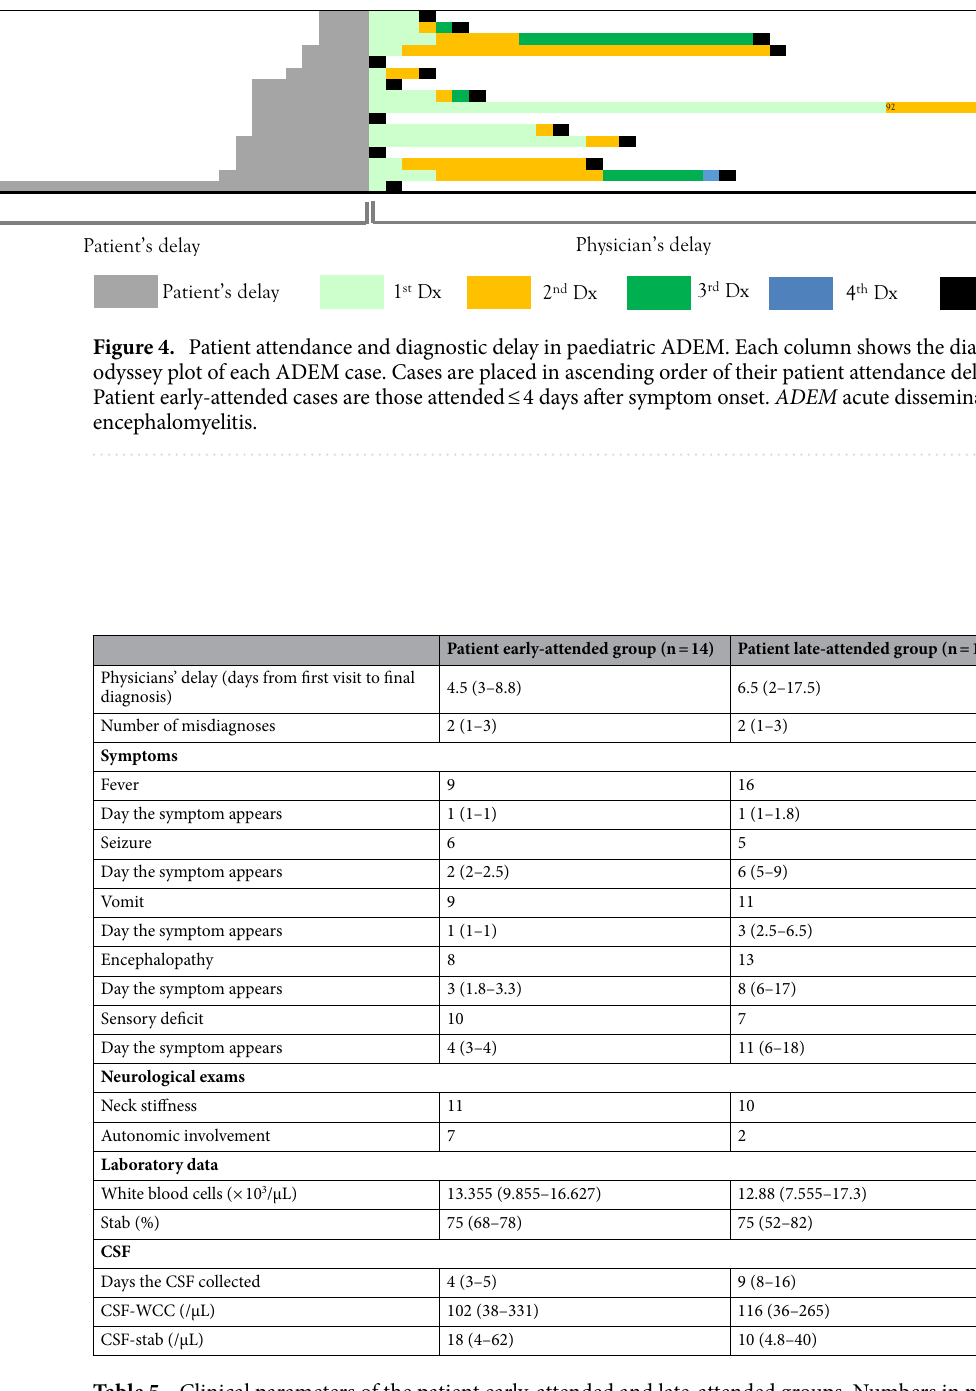
Table 5. Clinical parameters of the patient early-attended and late-attended groups. Numbers in parentheses denote interquartile ranges. CSF cerebrospinal fluids, ICU intensive care unit, EDSS expanded disability status score, NA not